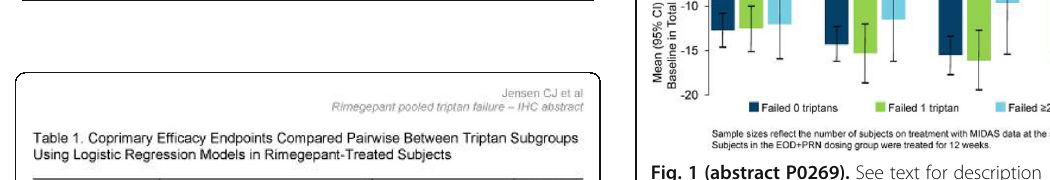
Fig. 1 (abstract P0268). See text for description